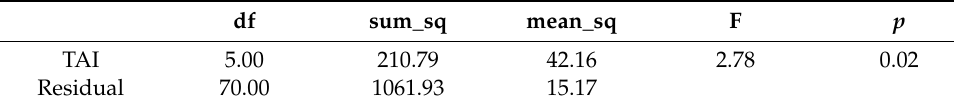
Table A2. ANOVA results for the time after irrigation effect on the